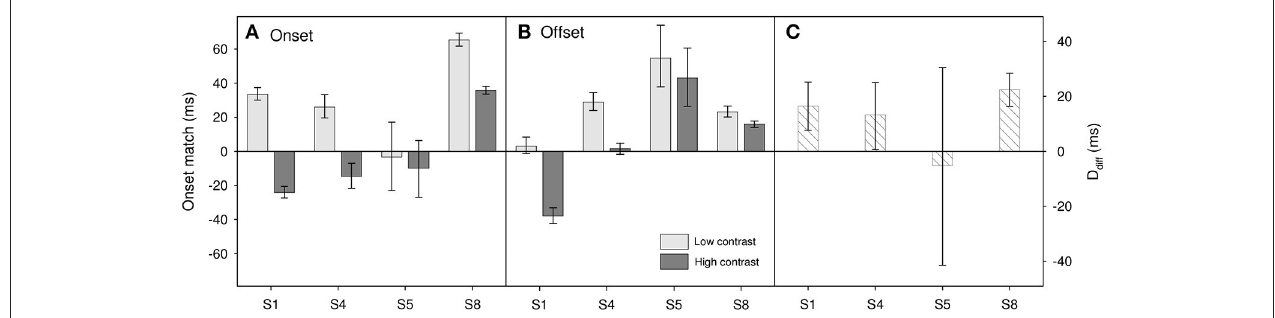
FIGURE 5 | Results for Experiment 3 for (A) onset matches and (B) offset matches. Light gray bars show matches for low contrast (0.1) stimuli, dark gray bars show matches for high contrast (0.9) stimuli. (C) Onset/offset resultant duration difference, D diff (see text for details). Error bars show 95% confidence limits.